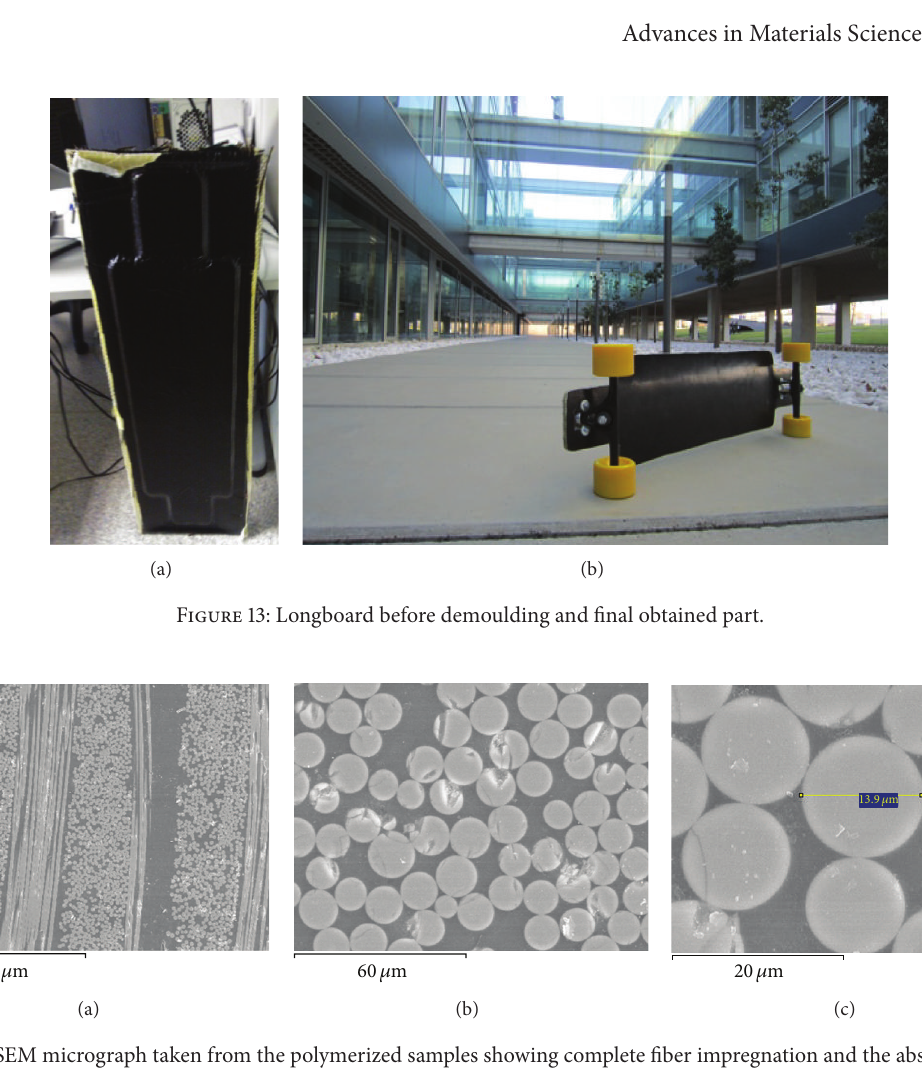
a longitudinal inlet parallel to the axis of the board.